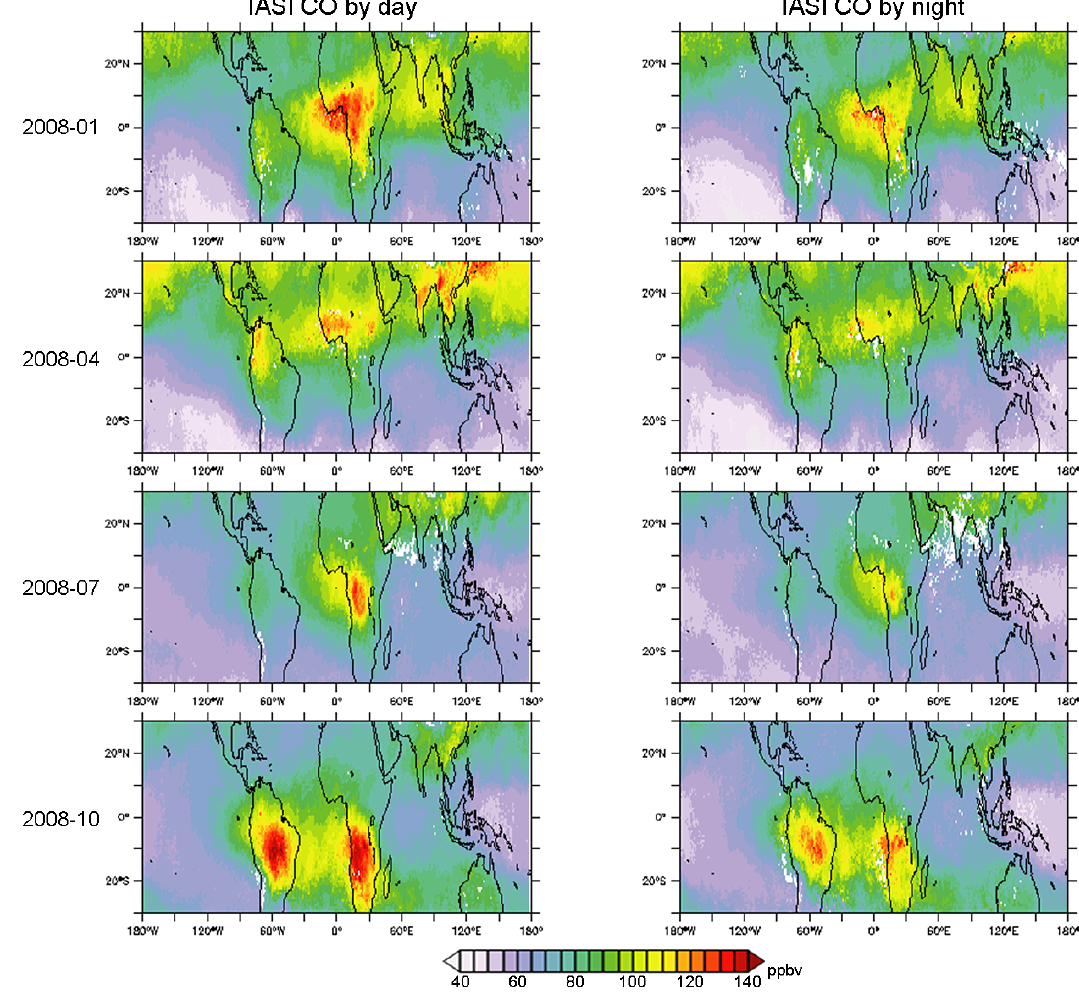
Figure 1. Monthly means of the integrated content of CO from IASI (ppbv), by day (09:30LT) (left) and by night (21:30LT) (right), in January, April, July and October 2008 in the